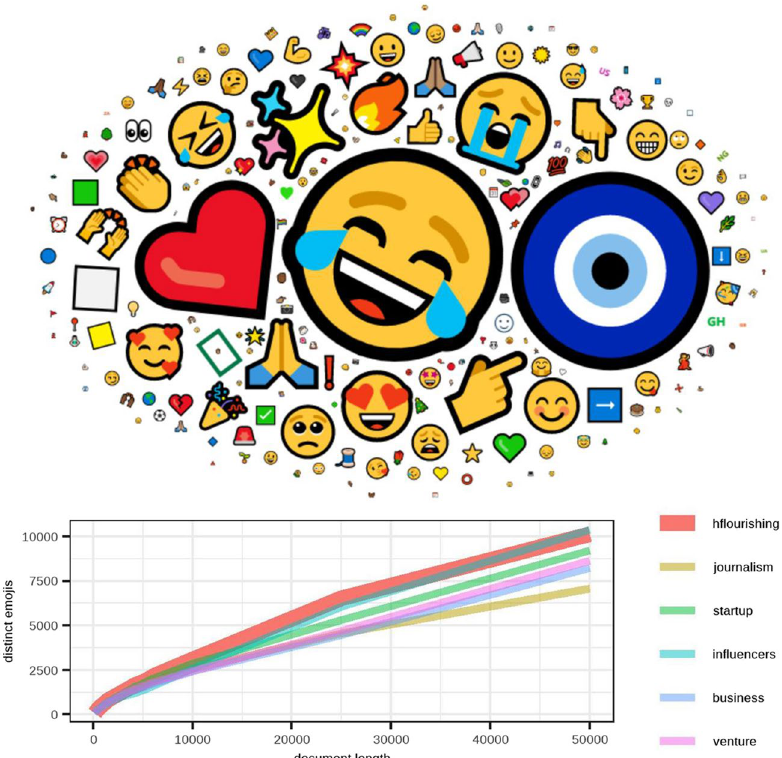
Figure 4. Cloud with the 100 most frequent emojis of the HF list with size proportional to their frequency of appearance. Below Heaps’ Law shows the richness of emojis in relation to the length of the document, where the HF list has been highlighted by harder and wider strokes. Graphics were made by the authors, using R